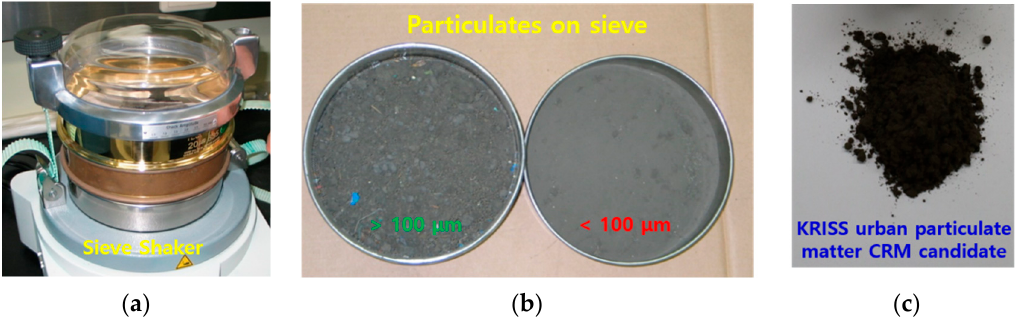
Figure 1. Picture of ( a ) sieve shaker; ( b ) > 100 µ m and < 100 µ m sieved KRISS urban dust CRM candidate; ( c ) powder form of KRISS urban dust CRM candidate ( < 100 µ m) for analysis.